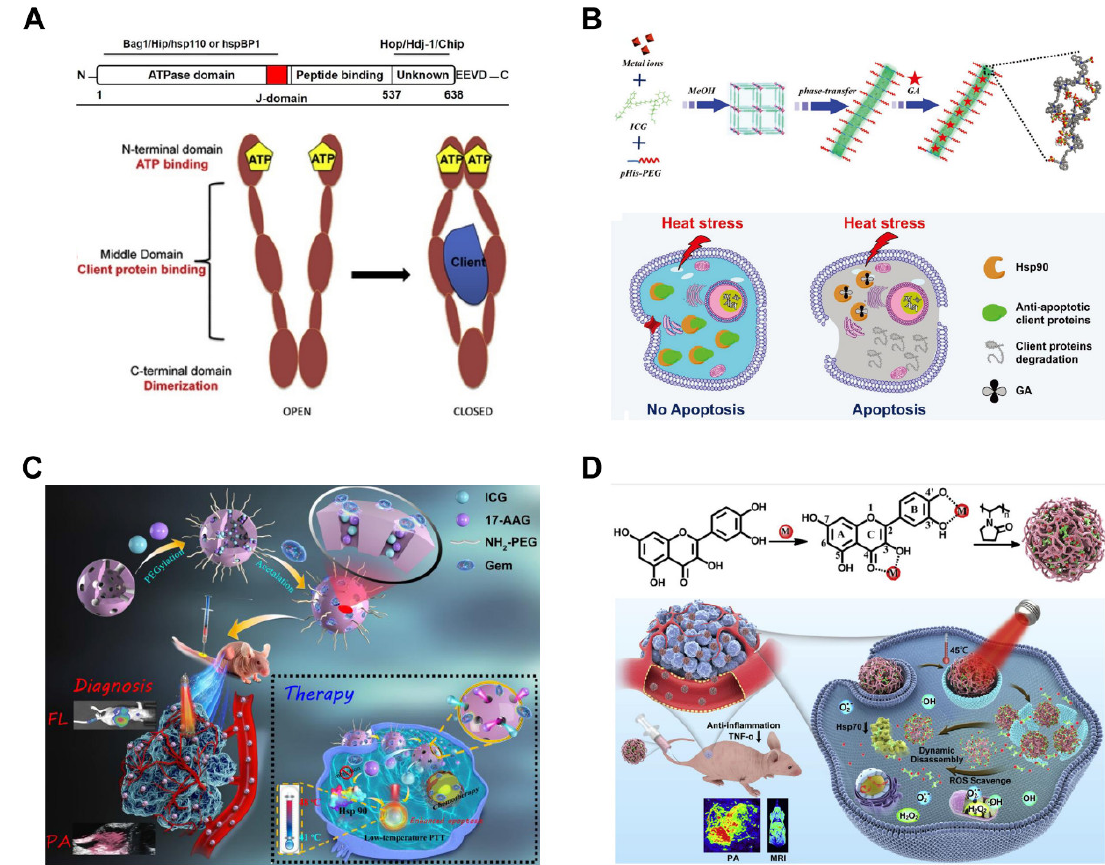
Figure 4. Several examples showing HSP70 and HSP90 inhibitors incorporated nanoplatforms that efficiently achieve MTPTT of the tumor. ( A ) Schematic representation of the structure and function of HSP70 and HSP90 [43,67]. Copyright © 2022 and 2016, Elsevier. ( B ) A scheme to illustrate a